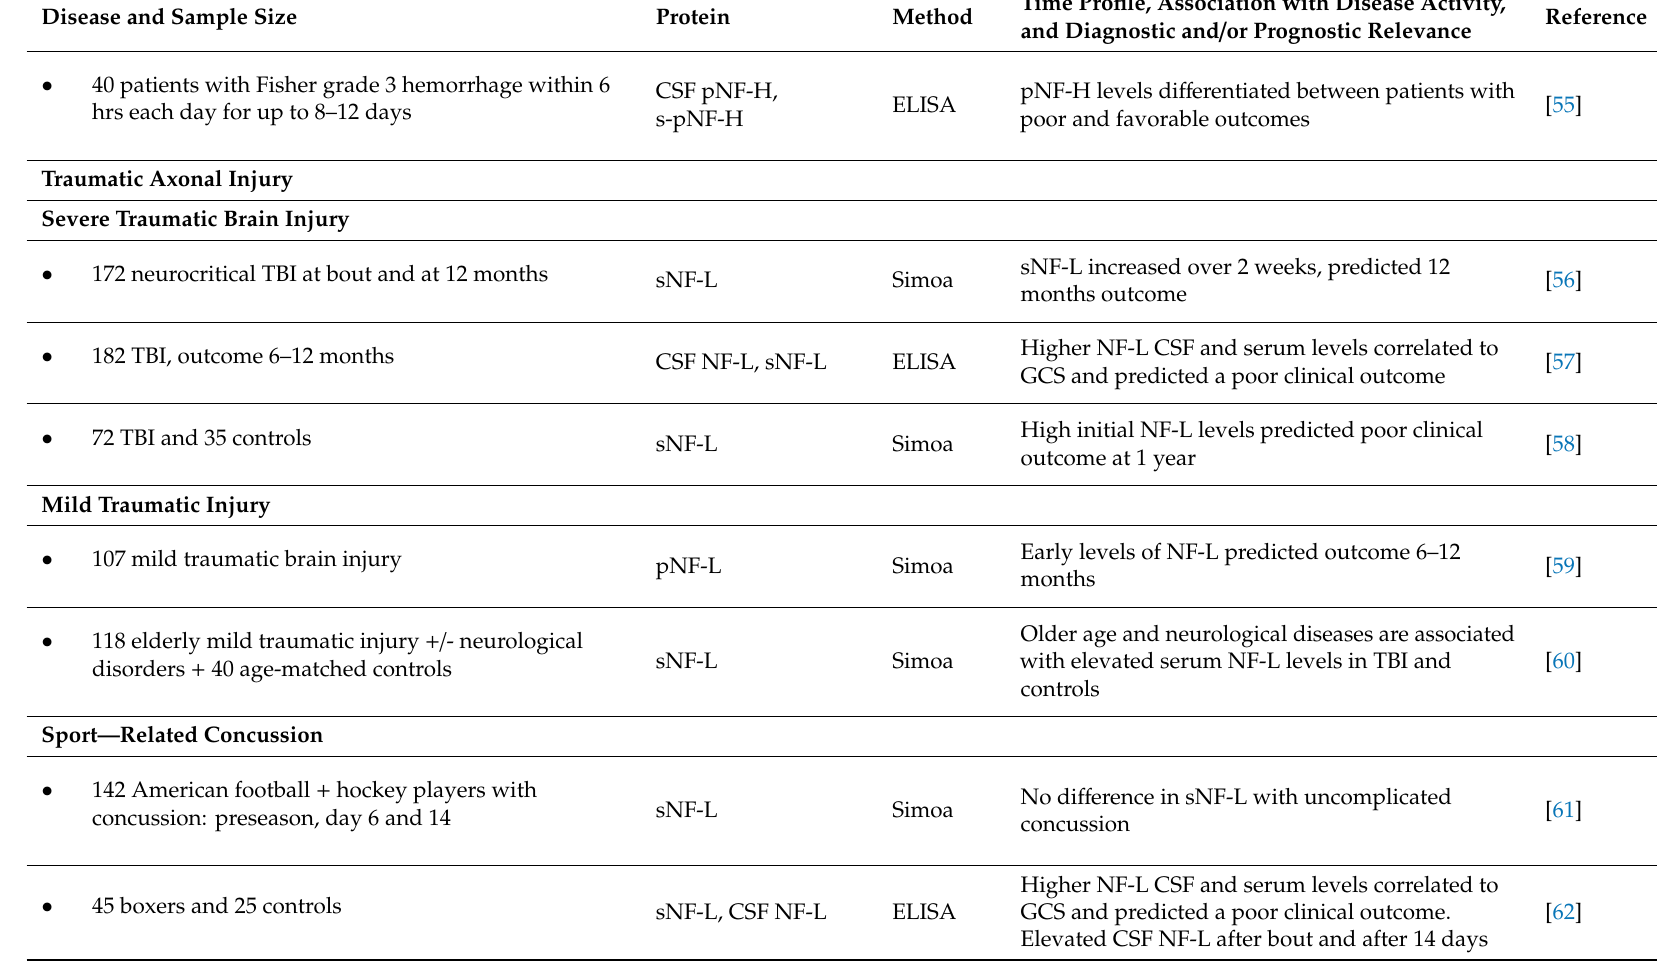
Disease and Sample Size Protein Method